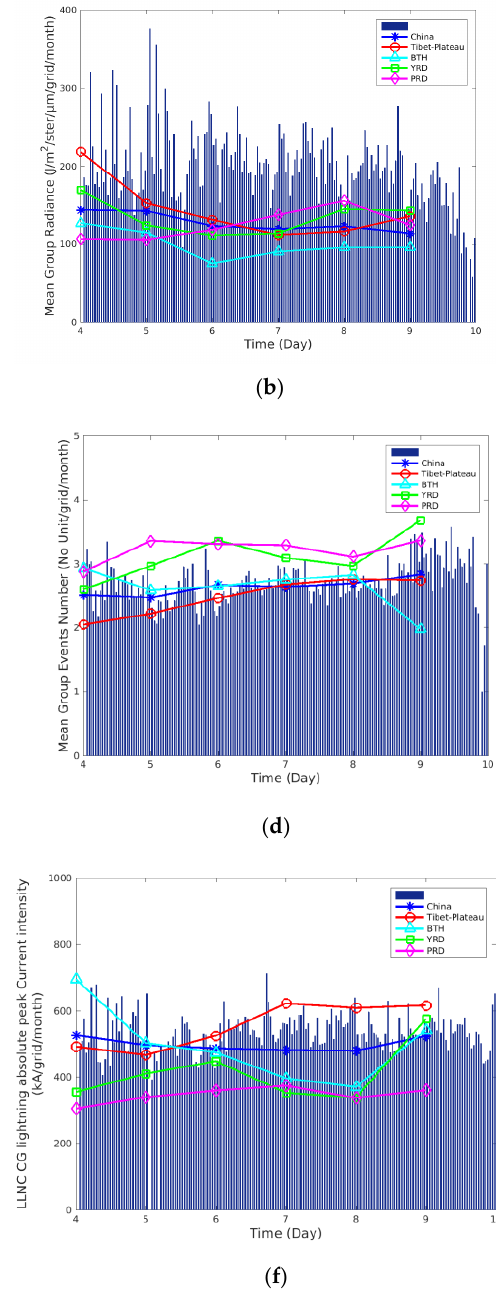
Figure 10. Temporal variation in the LMI Group and the LLNC lightning in China. ( a ) LMI Group density, ( b ) Radiance, ( c ) Footprint, ( d ) Group-Event number, ( e ) LLNC CG Event density, and ( f ) LLNC lightning current. The bar chart indicates the daily variation, while the line chart indicates the monthly variation.